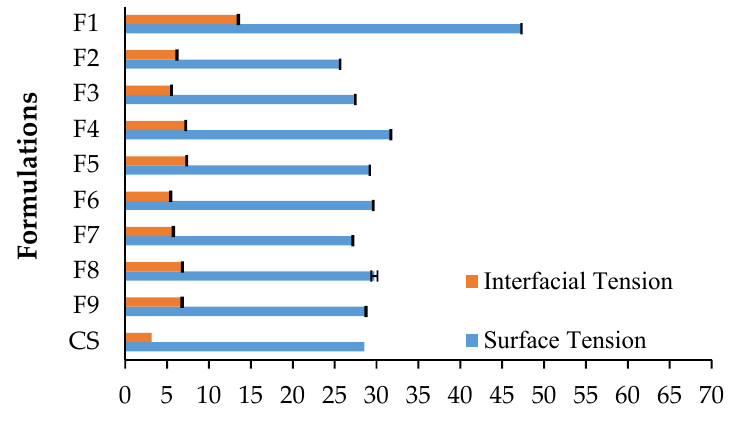
Figure 12. Surface and interfacial tensions of formulations tested in this study. The codes of the formulations are given in Table 7.